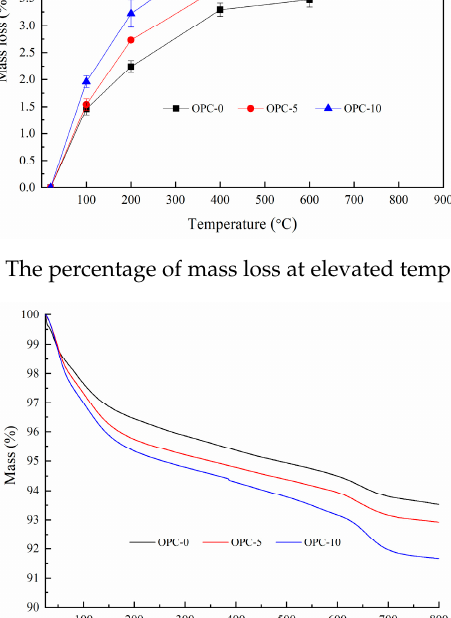
Figure 5. The TGA curves of low-calcium FAGC samples.